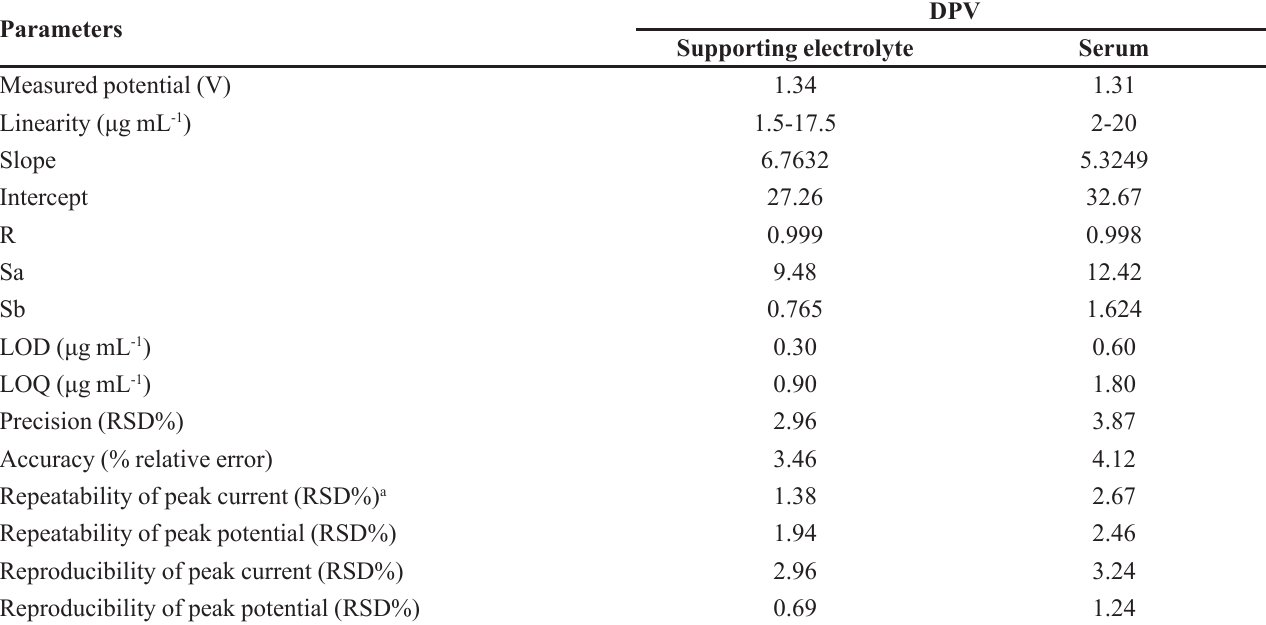
DPV Supporting electrolyte Serum